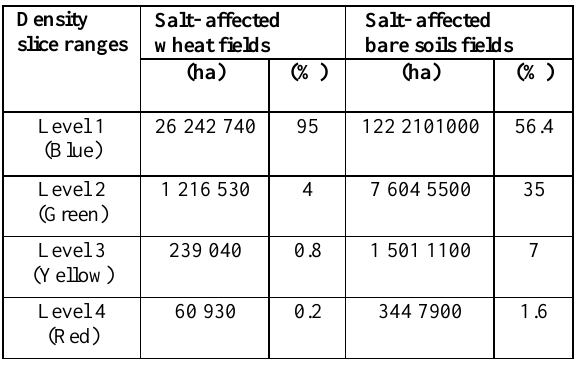
Table 6. The areal extent of the salt-affected wheat and salt-affected bare soils